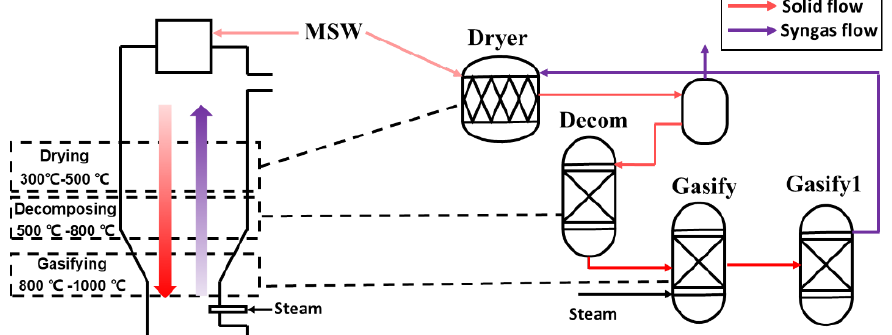
Figure 3. Comparison between the real updraft gasifier and simulation gasifier.